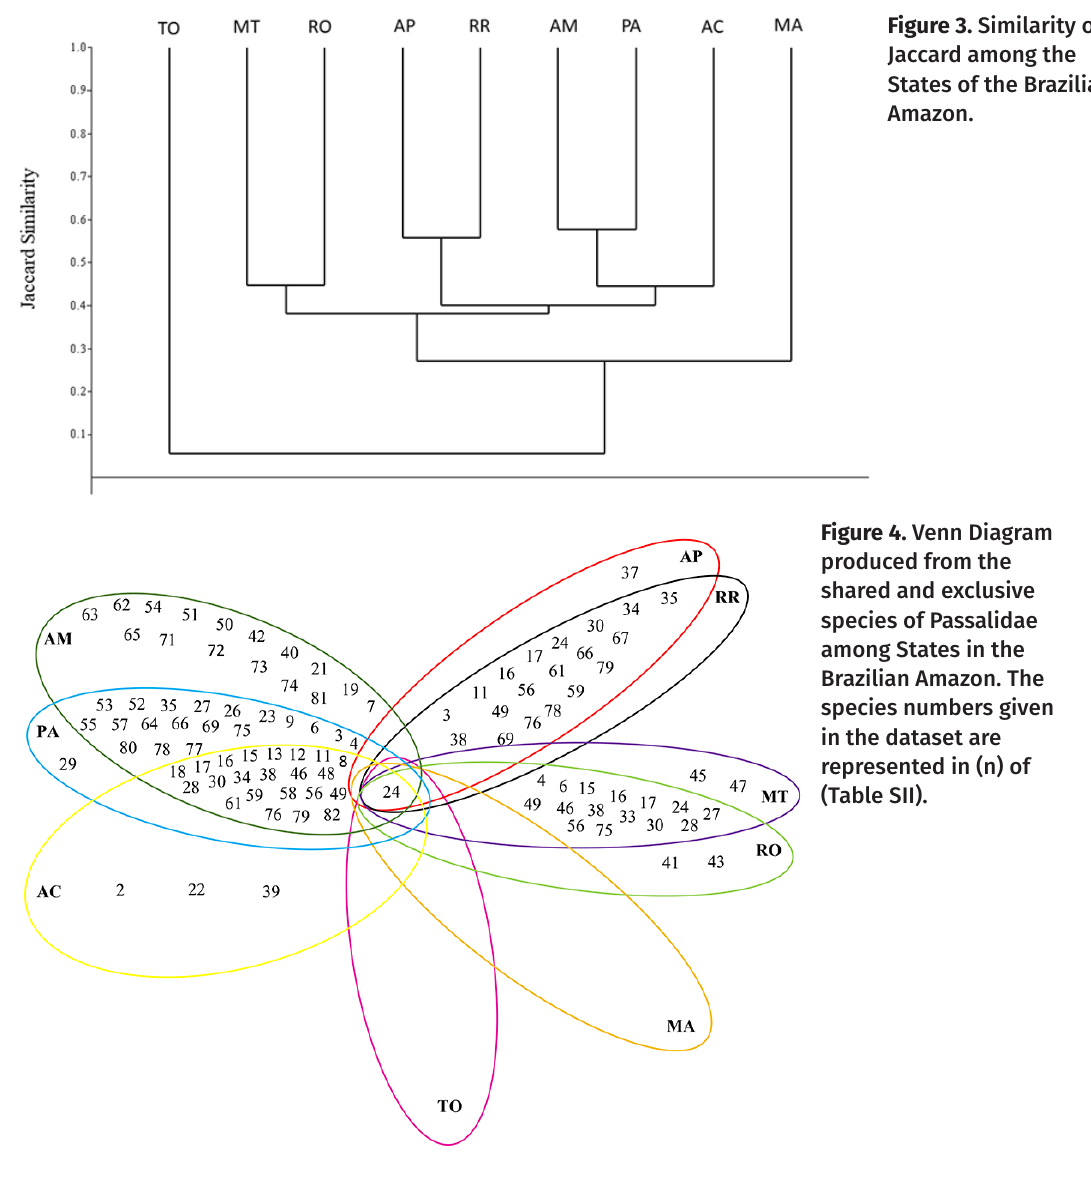
Figure 3. Similarity of Jaccard among the States of the Brazilian Amazon.